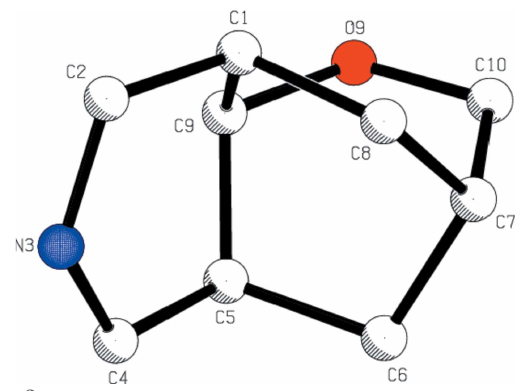
N—H groups are not involved in hydrogen-bonding interactions.